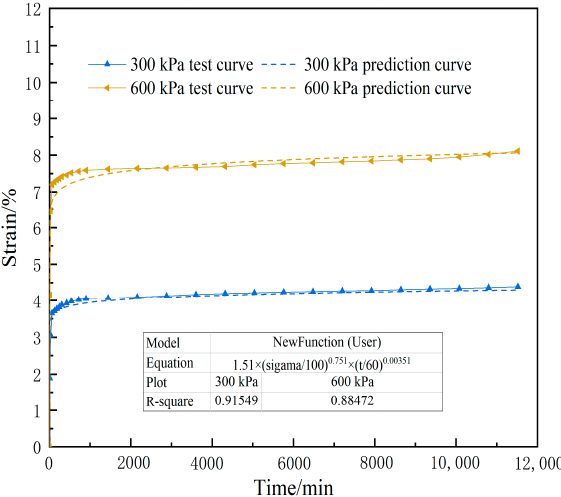
Figure 11. Comparison between prediction curve and test curve of sandy soil.